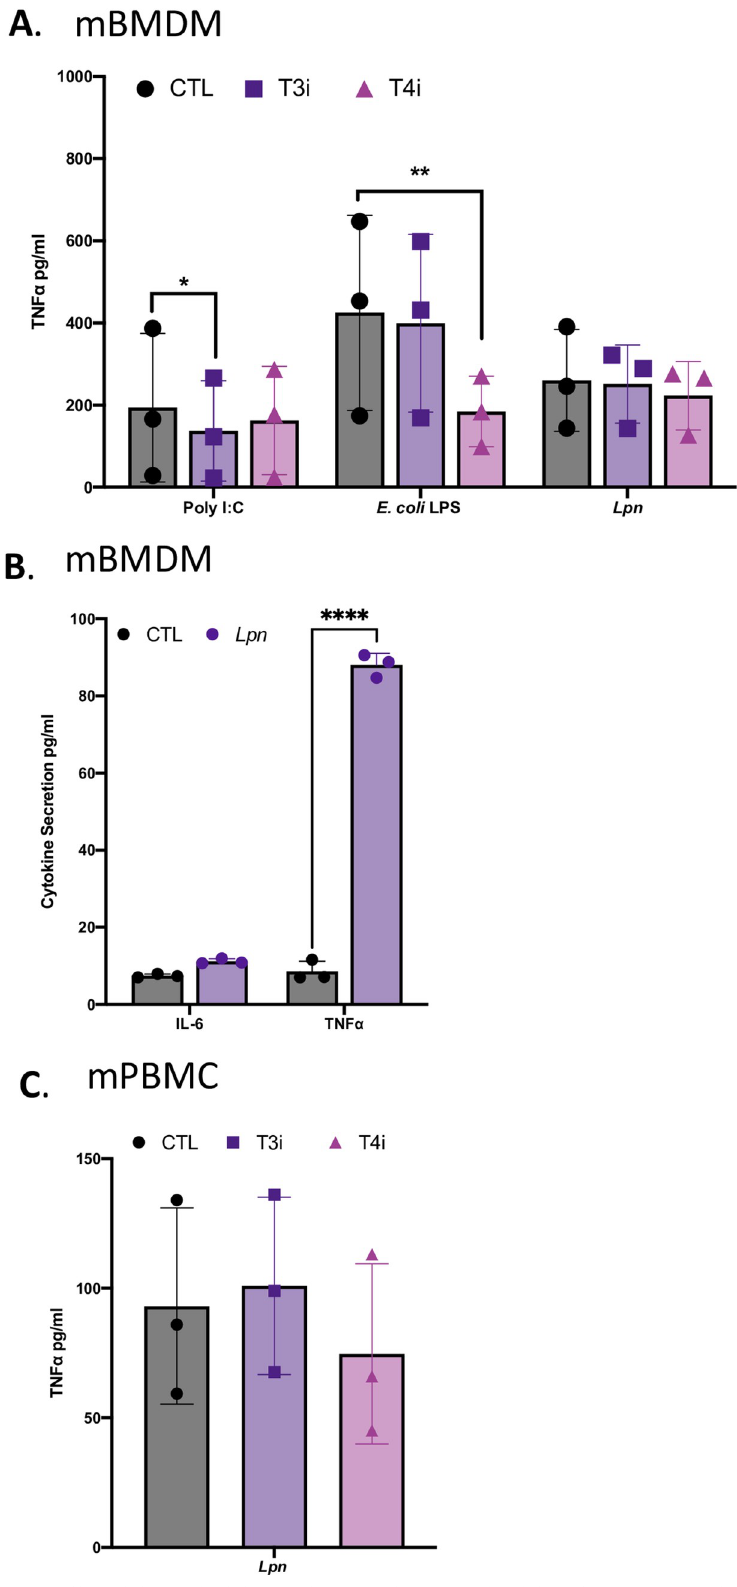
Fig 6. Effect of chemical inhibitors of TLR3 and TLR4 on the ability of murine macrophages to produce cytokines following L . pneumophila infection. ( A) Murine BMDMs (mBMDM) were pre-treated with either the TLR3 inhibitor Cu CPT 4a (T3i), TLR4 inhibitor TAK 242 at (T4i), or the vehicle control, DMSO (CTL), and then, following either 11 PLOS Pathogens| https://doi.org/10.1371/journal.ppat.1009781 July 19,